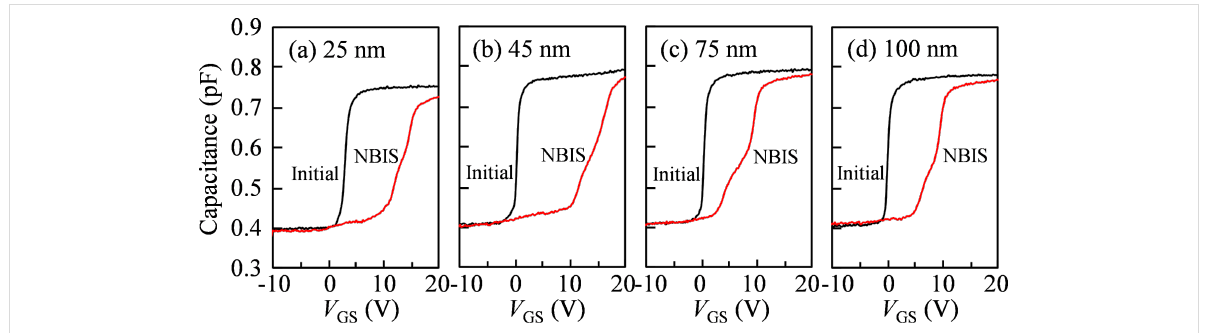
ment, and show the small shift of 9.45 and 9.96 V in the posi- to T IGZO = 75 and 100 nm,